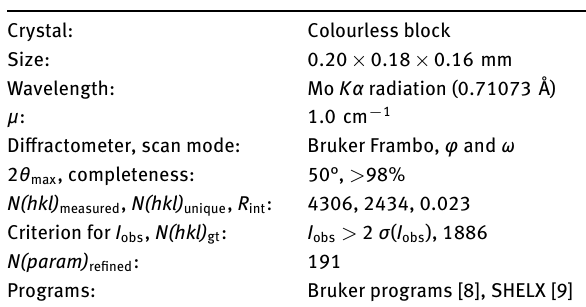
Table 1: Data collection and handling.